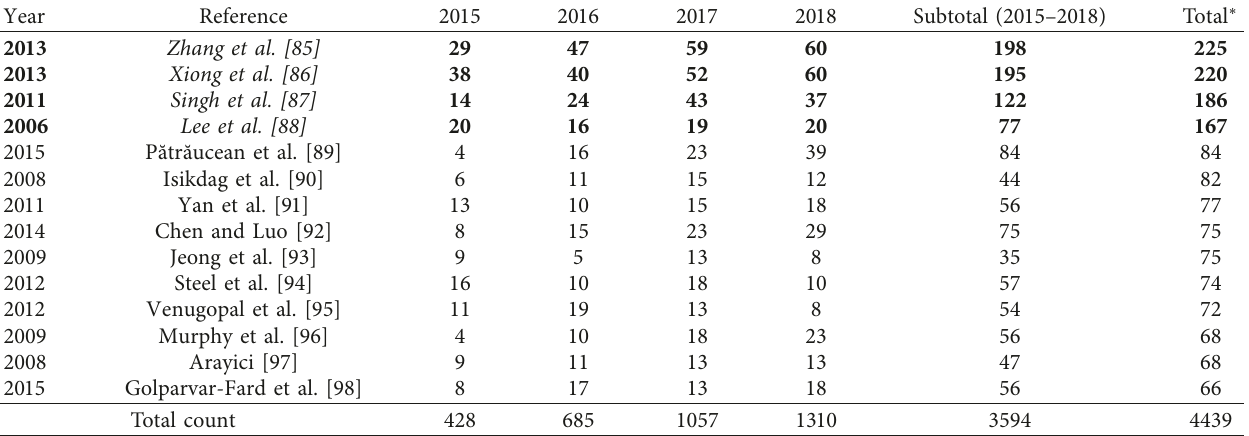
Table 7: The most cited articles on BIM in the area of structural engineering excluding